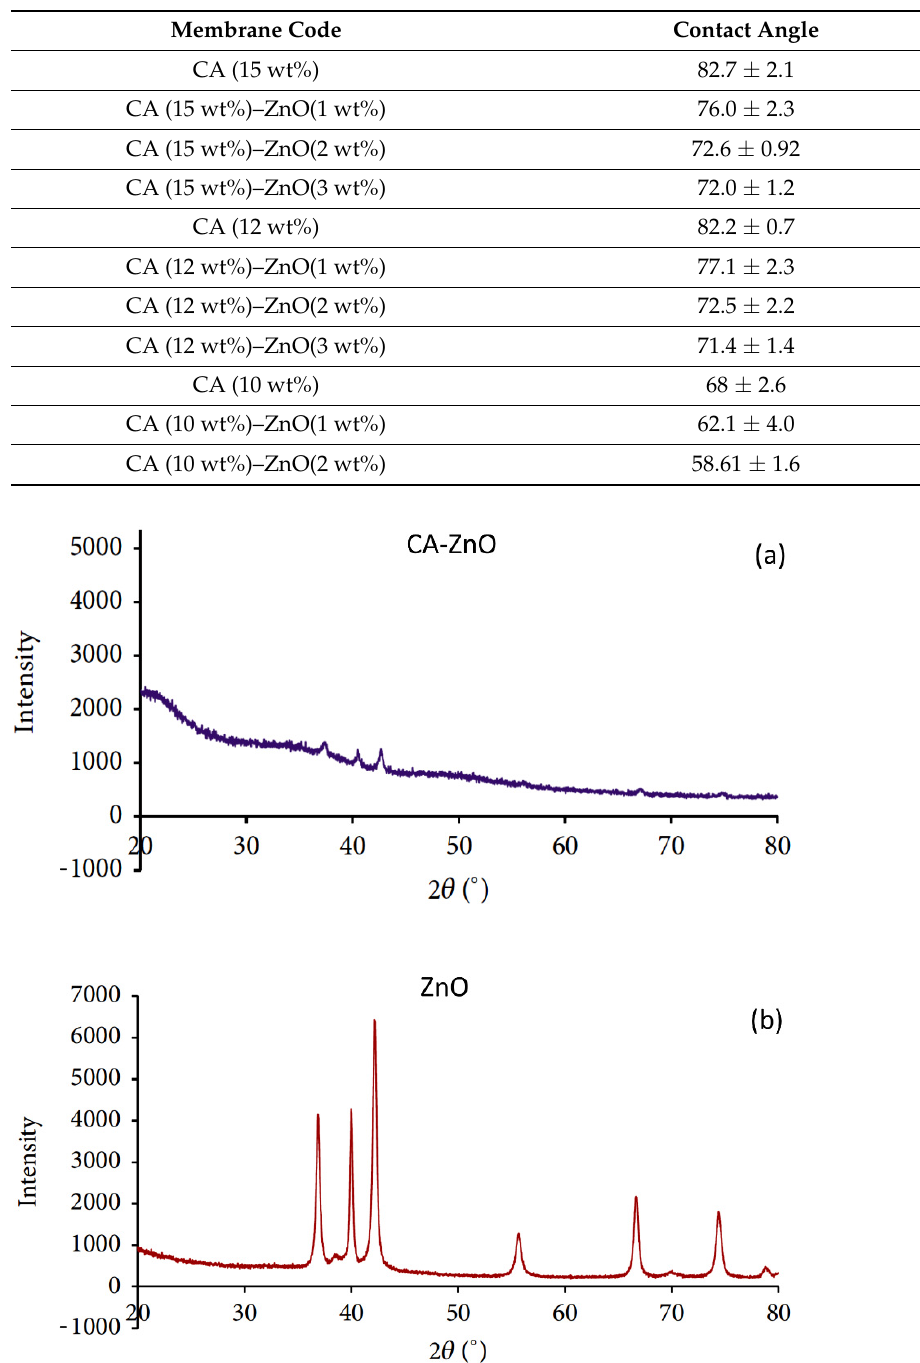
Table 3. Water contact angle measurement.